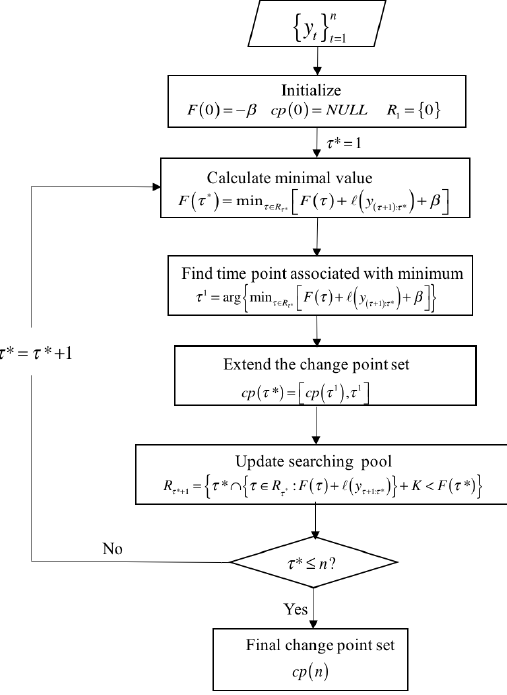
Figure 1. Pruned exact linear time (PELT) algorithm